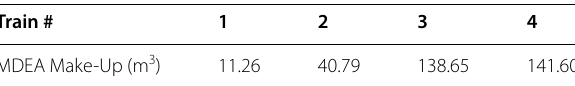
Table 9 MDEA make-up in gas sweetening unit train #1 to #4 Train